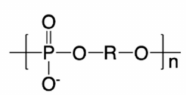
Figure 1. General structure of polyphosphodiesters